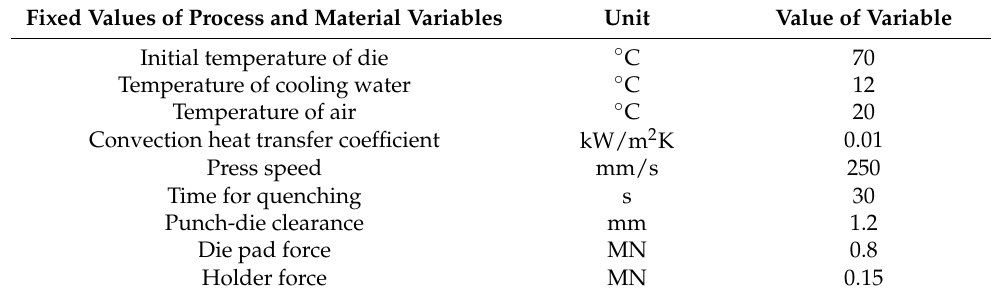
Table 3. Fixed values of process and material variables used for B-pillar hot stamping forming analysis. Fixed Values of Process and Material